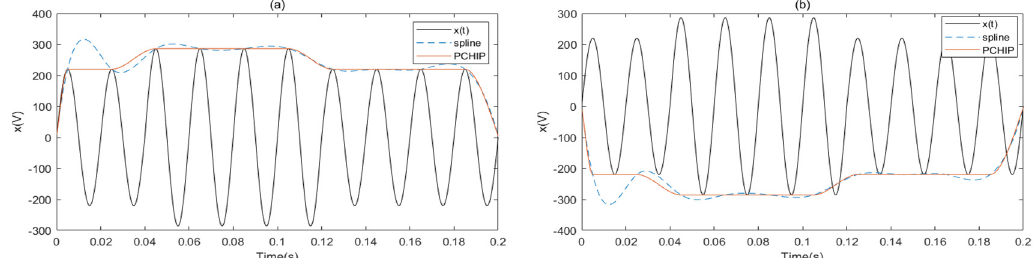
Figure 2. Voltage swell signal upper ( a ) and lower ( b ) envelopes.